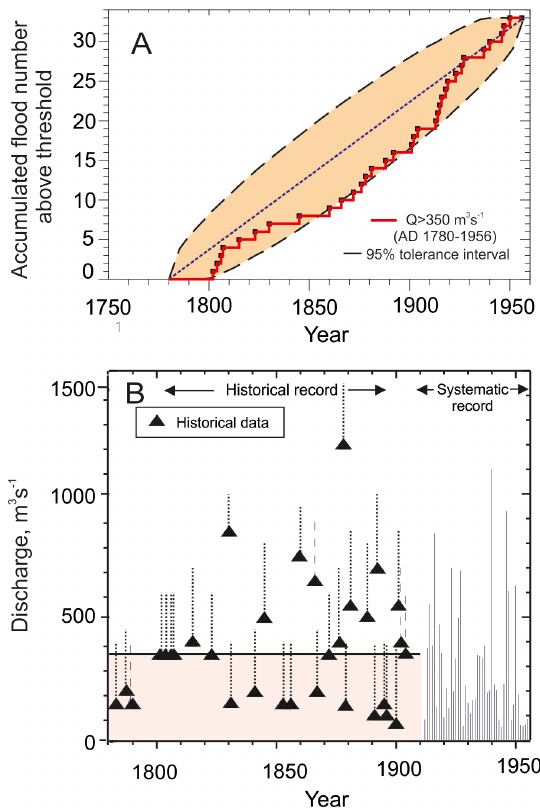
Figure 4. (a) Poisson test on the time flood process in the Aran- juez record for the period 1780–1956, for floods exceeding a dis- charge threshold of 350m 3 s − 1 . Note that the flood series (central line connecting points) remain within the 95% tolerance interval (outside enveloped curves). (b) Organisation of historical and sys- tematic flood data, for flood frequency